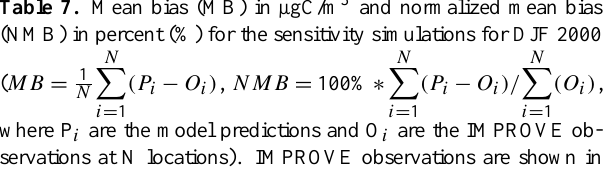
Fig. 7. Sensitivity simulations are outlined in Table 6. 2 ◦ × 2 . 5 ◦ simulations use GEOS4 meteorology. 4 ◦ × 5 ◦ simulations use GISS GCM meteorology.